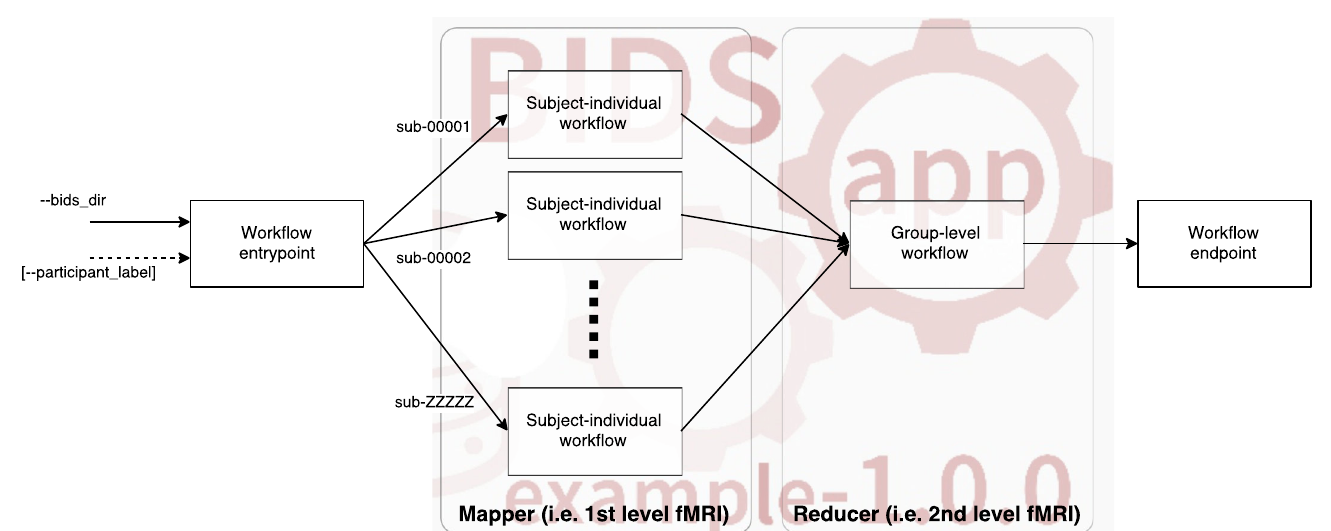
Fig 2. The overall structure of workflows. Workflows will need to decouplethe individuallevel analysis(process independentsubjects) from the group-levelanalysis. For the analysisof individualsubjects, the workflow will require an understanding of the BIDS structure so that the requiredinputs for the designated subject are found. The optional reducer module will take up from results generated in the mapper and generatea group output. The overall workflowhas an entrypoint and an endpointresponsible of setting-up the map-reducetasks and the tear-down includingorganizingthe outputs for its archiving, respectively. Please mind that each app can implementmultiple map and reduce steps (see Advanceduse